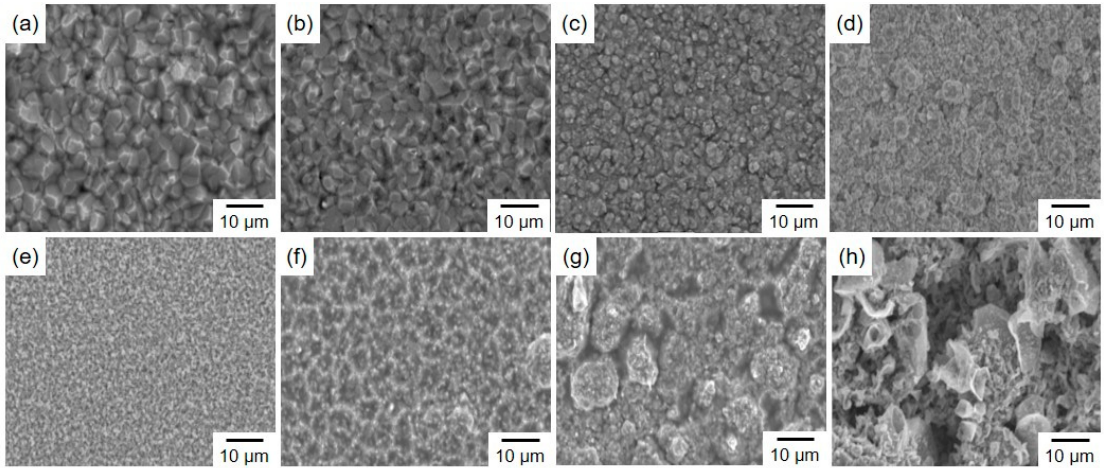
Figure 4. SEM image of the surface of the Sn-Zn alloy films (cathode current density; ( a ) 0.5 mA / cm 2 , ( b ) 1 mA / cm 2 , ( c ) 2 mA / cm 2 , ( d ) 3 mA / cm 2 , ( e ) 5 mA / cm 2 , ( f ) 7 mA / cm 2 , ( g ) 10 mA / cm 2 , ( h ) 15 mA / cm 2